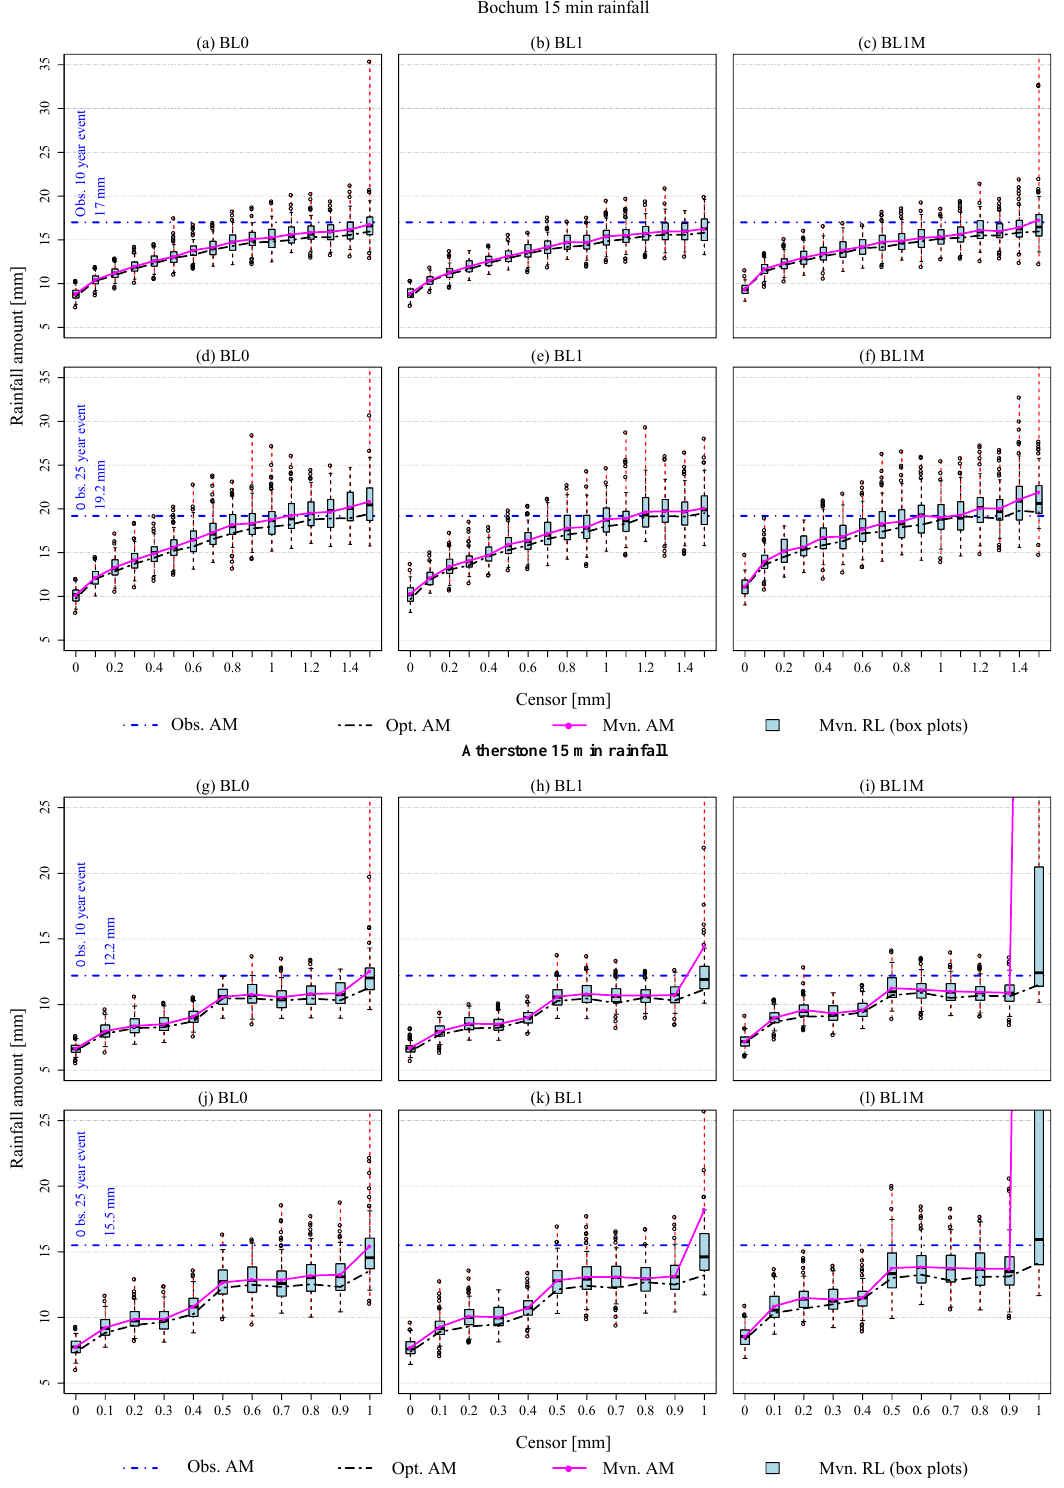
Figure 12. Variation in extreme value estimation with censors for 15min data at Bochum and Atherstone for two annual return periods: 10 and 25 years. Plots show the optimal realizations (opt. AM), the means of the MVN realization (mvn. AM), and the spread of the individual realizations (mvn. RL) with box